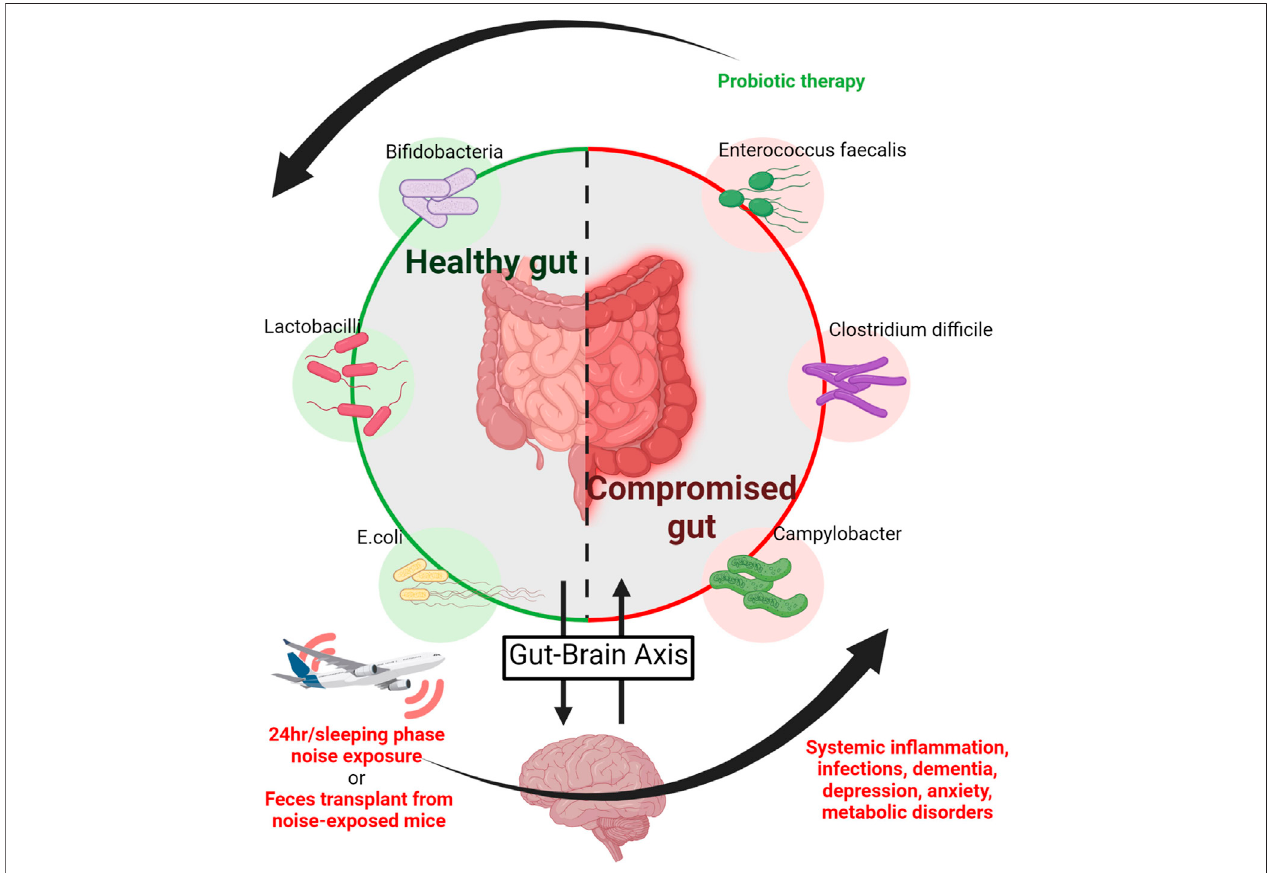
FIGURE 5 | Noise and the microbiome. The gastro-intestinal microbiome is connected to neuropsychiatric processes via the gut-brain axis and thereby affects neuropsychiatric disorders, whereas mood and neuropsychiatric health may affect intestinal in fl ammatory disease (Collins et al., 2012; Cryan and Dinan, 2012). Noise causesneuronalactivationwithsubsequentstresshormonereleaseandisassociatedwithannoyance,depressionanddementia.Accordingly,noisetriggersalterations ofthegut-brainaxisleadingtoashifttoharmfulbacteriaintheintestineassociatedwithcognitiveimpairmentandA β accumulationinamurinemodelofAlzheimer ’ s disease(Cuiet al.,2018).Noise alsodisrupts theequilibriumofintestinalpro-oxidativeand antioxidant mechanismsinassociationwithlow-grade systemicin fl ammation in mice (Chi et al., 2021) and generally causes an imbalance of health-compromising versus -promoting bacteria together with impaired mental health. As a proof-of- concept these adverse health effects of noise where mostly corrected by probiotic therapy (Hadizadeh et al., 2019), whereas feces transplantation from noise-exposed tounexposedmiceinducedtheabovementionedhealthcomplications(Cuietal.,2018).Imagewascreated usingBiorender.combymodifyingthecentralschemefrom https://de.freepik.com/vektoren-premium/menschlicher-doppelpunktvektor-der-guten-bacterial- fl